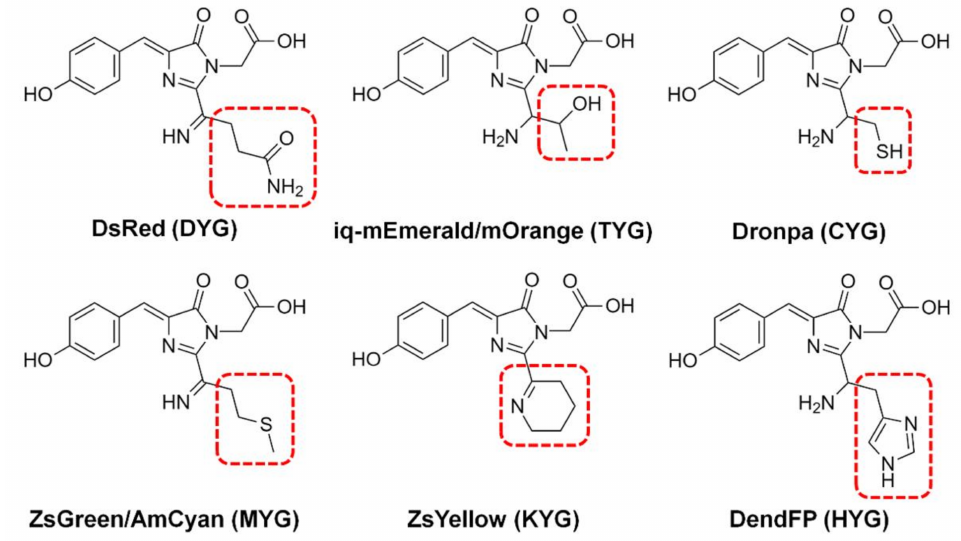
Figure 1. Chromophores of fluorescent proteins showing fluorescence quenching by metals. The chromophore tripeptide sequence is shown in